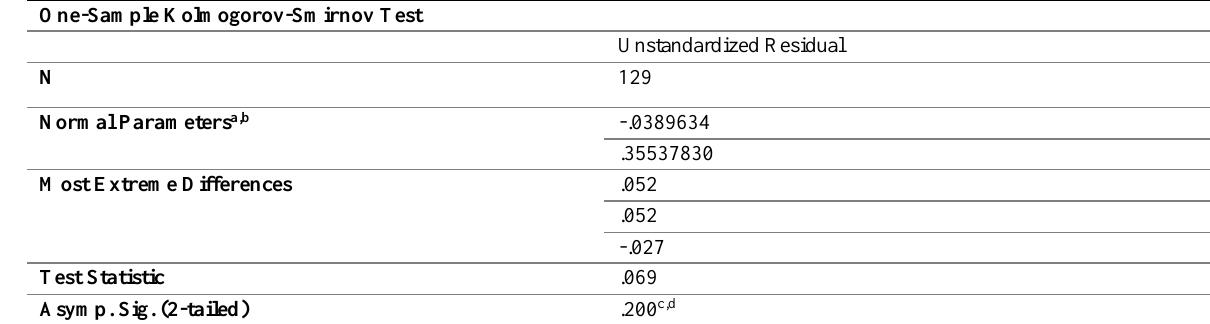
Table 1: Normality Test.